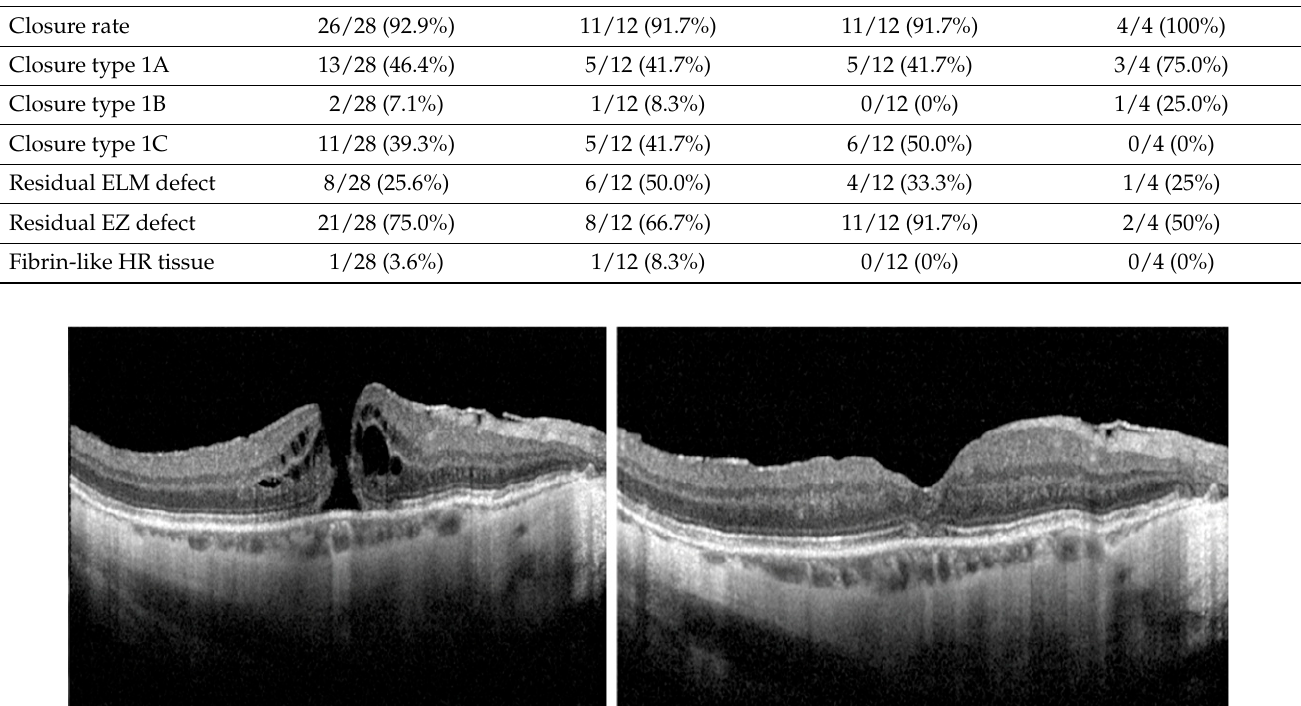
Figure 1. Case 1: A full-thickness refractory macular hole (rFTMH) of a highly myopic eye that did not close after a primary 25-G pars plana vitrectomy (PPV) with internal limiting membrane peeling ( left ). At 6 months after secondary PPV with autologous platelet-rich plasma and gas tamponade, complete closure of rFTMH is seen ( right ).